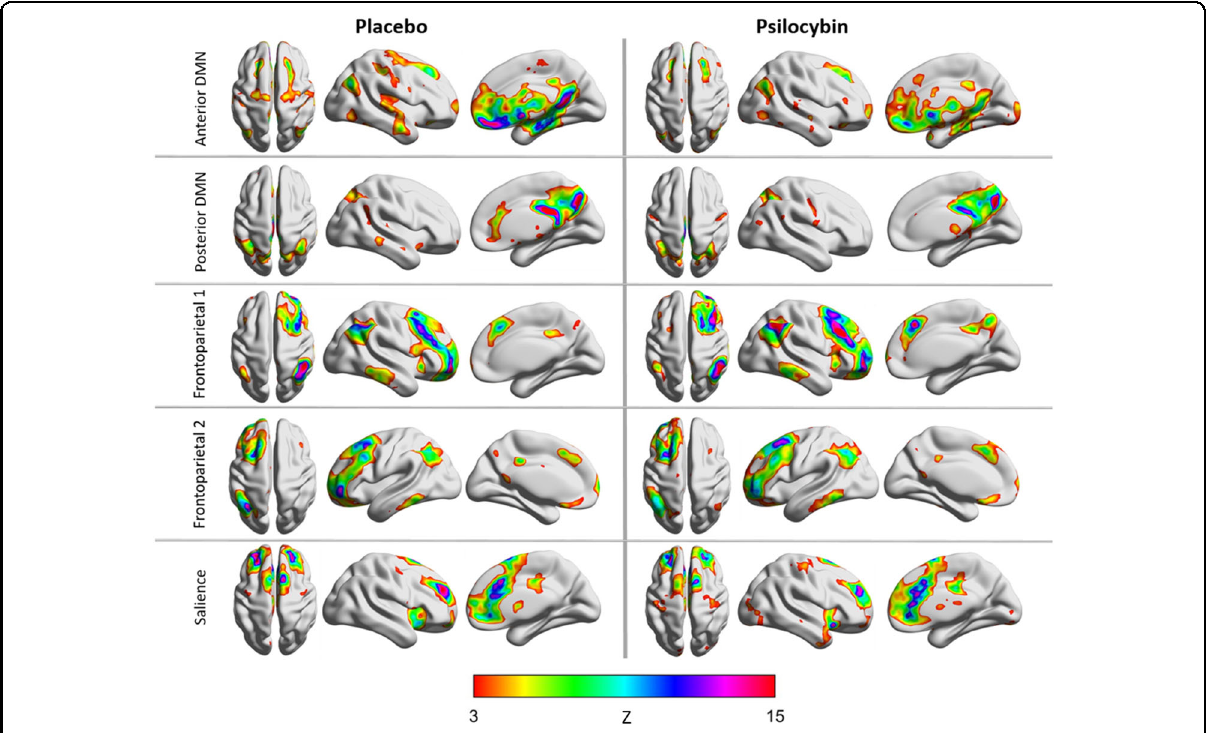
Fig. 2 Resting-state networks implicated in creative cognition, for each group (placebo and psilocybin). The anterior and posterior DMN demonstrated signi fi cant differences in within-network functional connectivity between groups.